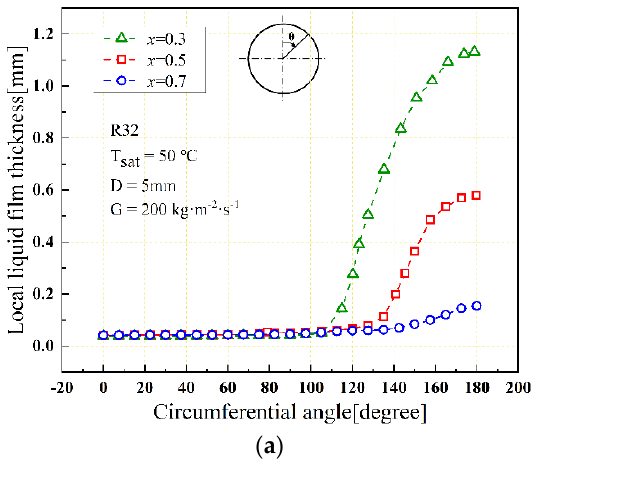
Figure 6. Local liquid film thickness and local heat transfer coefficient versus circumferential angle at different vapor quality under mass flux G = 200 kg/(m 2 ·s). ( a ) Local liquid film thickness; ( b ) local heat transfer coefficient.